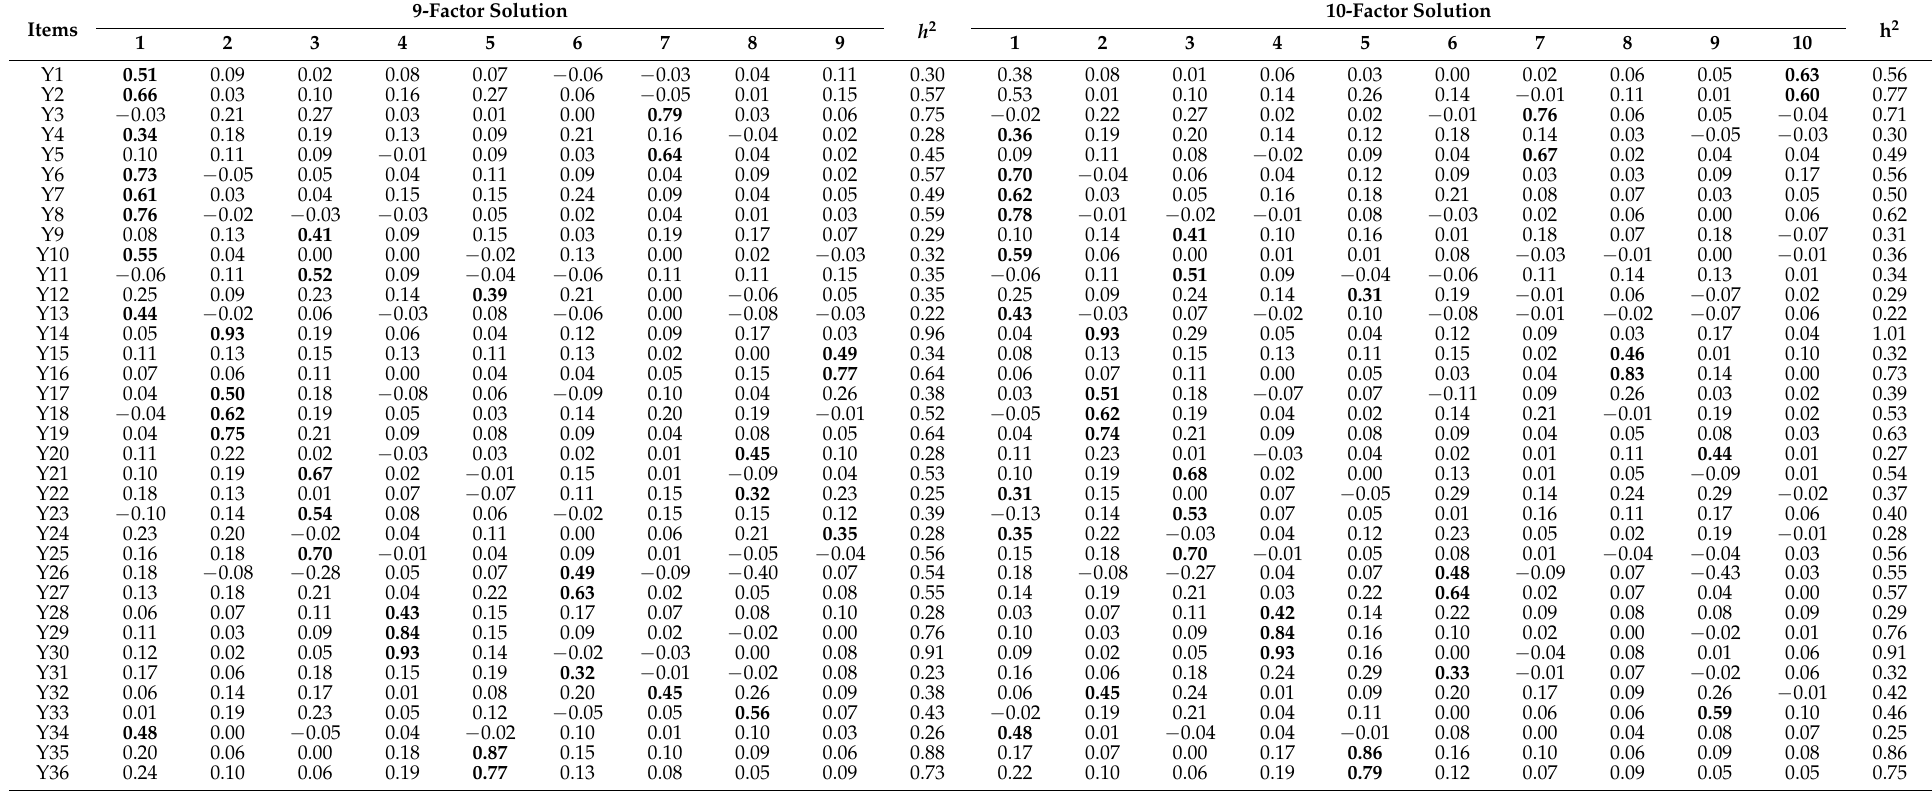
Table 4. Item-factor loadings from EFA for the nine-factor solution and ten-factor